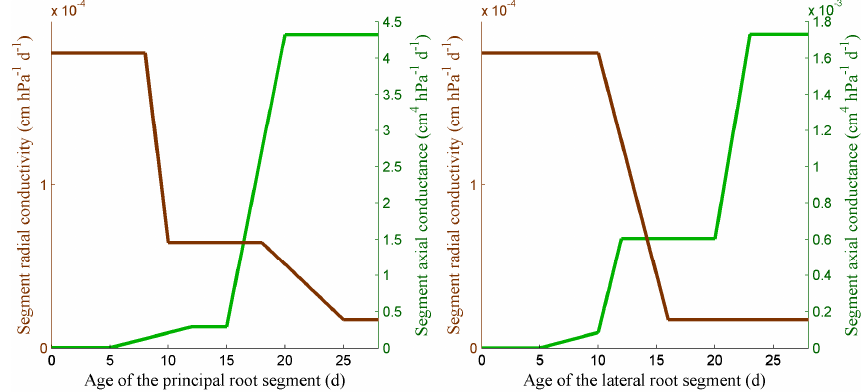
Fig. 3. Maize root segment hydraulic properties expressed as a function of age and type. 3 branches that crossed the vertical boundaries of the periodic domain (in